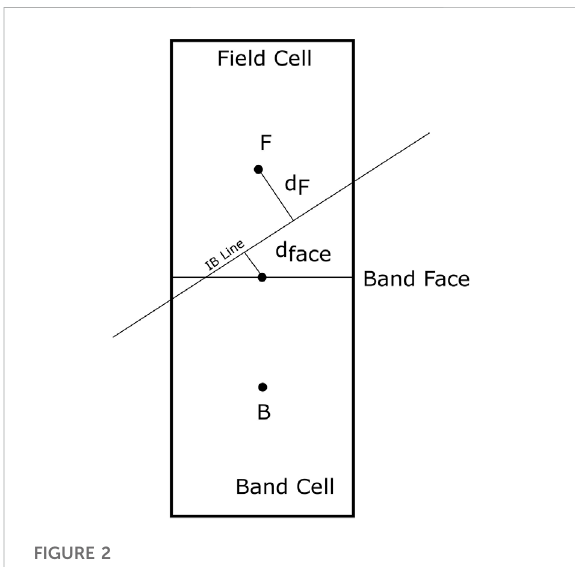
FIGURE 3 Distance nomenclature for the no-slip wall